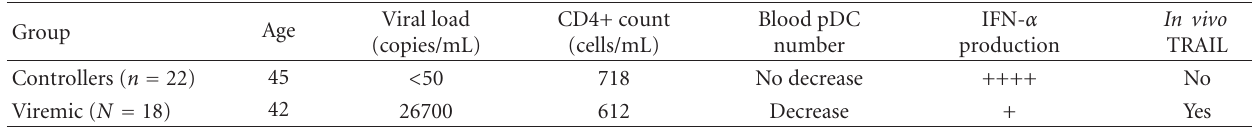
Figure 1: Comparison between HIV-1 viremic patients and HIV-1-Infected controllers during the di ff erent phases of infection. Viral load and lymphopenia controlled in HIV controllers versus viral load and lymphopenia uncontrolled in viremic. Decrease of IFN- α production versus no decrease of IFN- α production in viremic. Table 1: Characteristic of HIV controllers and viremic